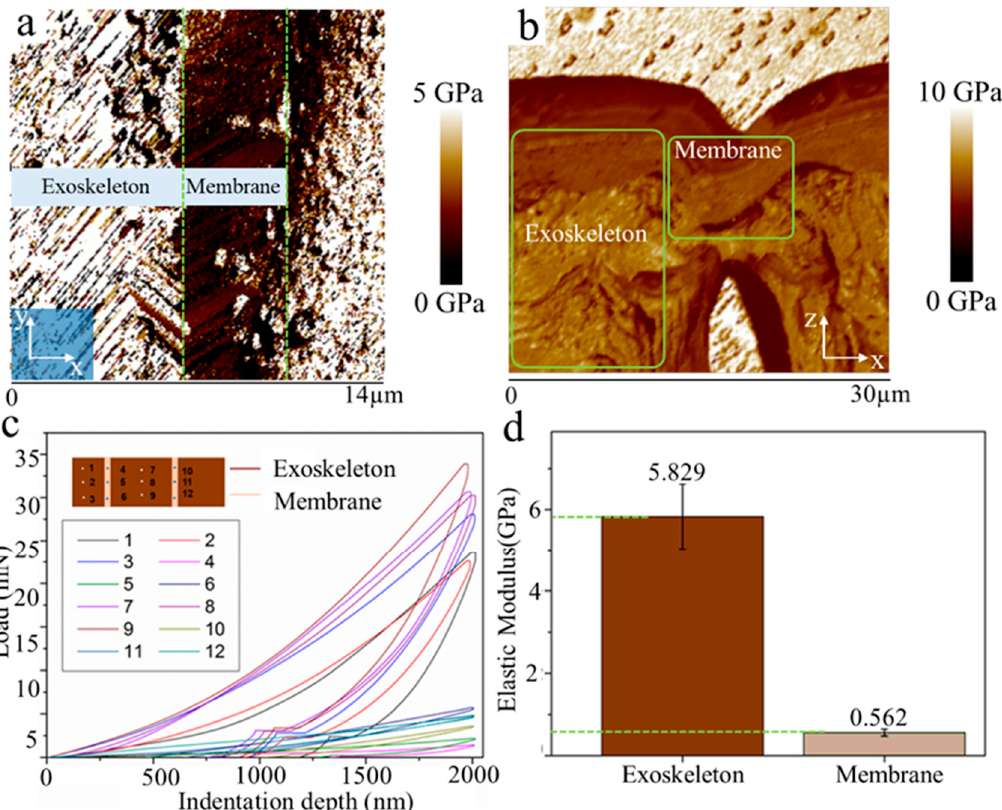
Figure 3. ( a ) Elastic modulus map of tissue around a slit wake under fresh conditions; ( b ) elastic modulus map of tissue in dehydrated state; ( c ) nano-indentation load displacement curves of membrane tissue and exoskeleton, respectively; ( d ) the elastic modulus of exoskeleton and membrane tissue calculated based on the curves in (c).